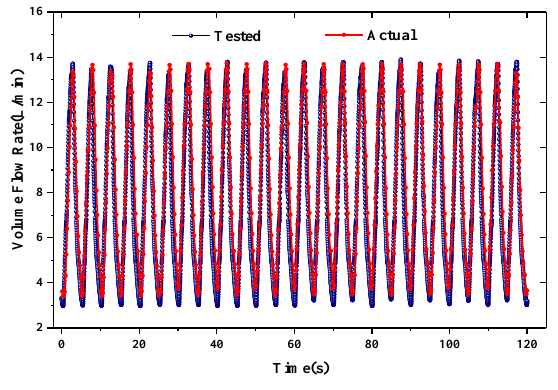
Figure 11. Experimental setup for respiration simulation.